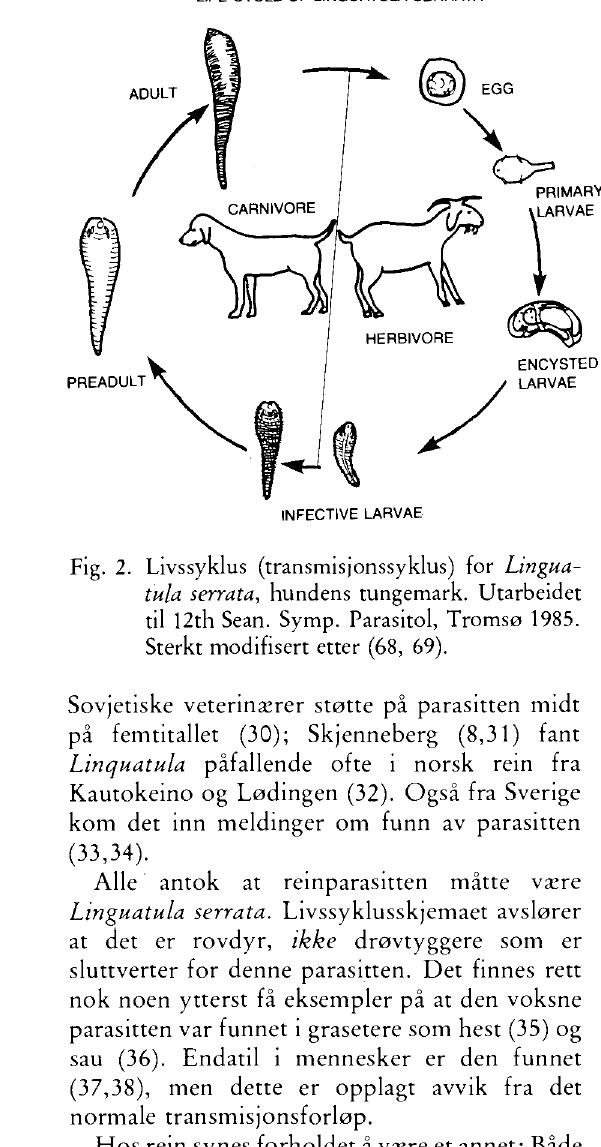
Fig. 3. Sannsynlig livssyklus (transmisjonssyklus) for Linguatula arctica, reinens bihulemark. Fra Haugerud og Nilssen